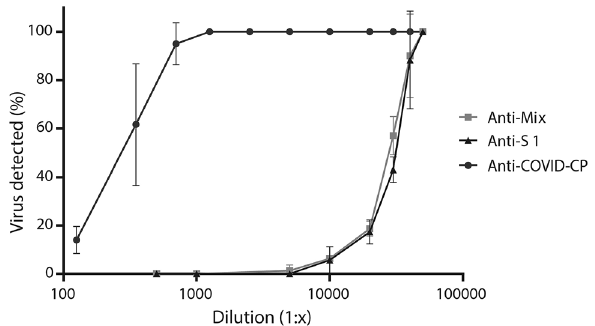
Figure 5. In vitro neutralization of SARS-CoV-2 virus by anti-S1 and anti-Mix formulations and human convalescent plasma (Anti-COVID-CP). Samples were serially diluted and their neutralization ability was assessed by a Plaque Reduction Neutralization (PRNT) assay over Vero cells. Results are expressed as mean ± SD of triplicates. ED 50 (95% CI), based on the ability of the preparations to neutralize 50% of the virus was 1:29,108 (1:26,885–1:31,643), 1:25,355 (1:22,659–1:58,594), and 1:339 (1:295–1:386) for anti-S1 formulation, anti-Mix formulation and human convalescent plasma, respectively.